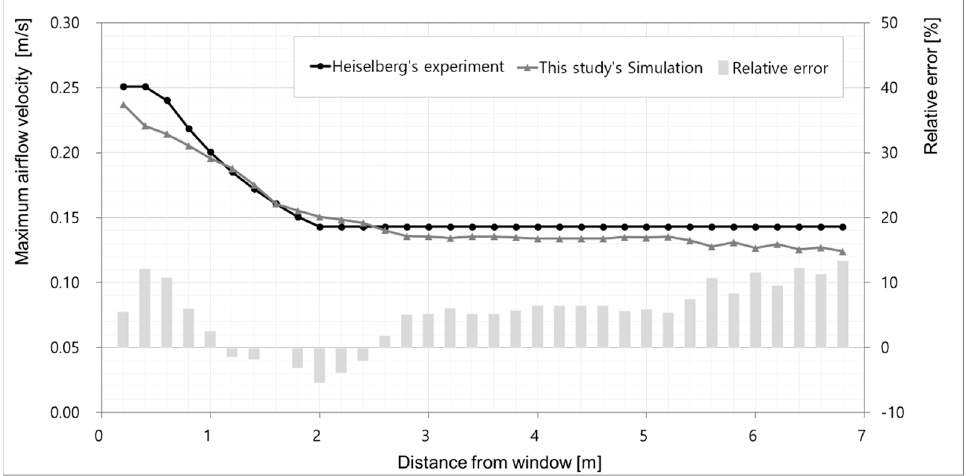
Figure 6. Result of maximum airflow velocity comparison.